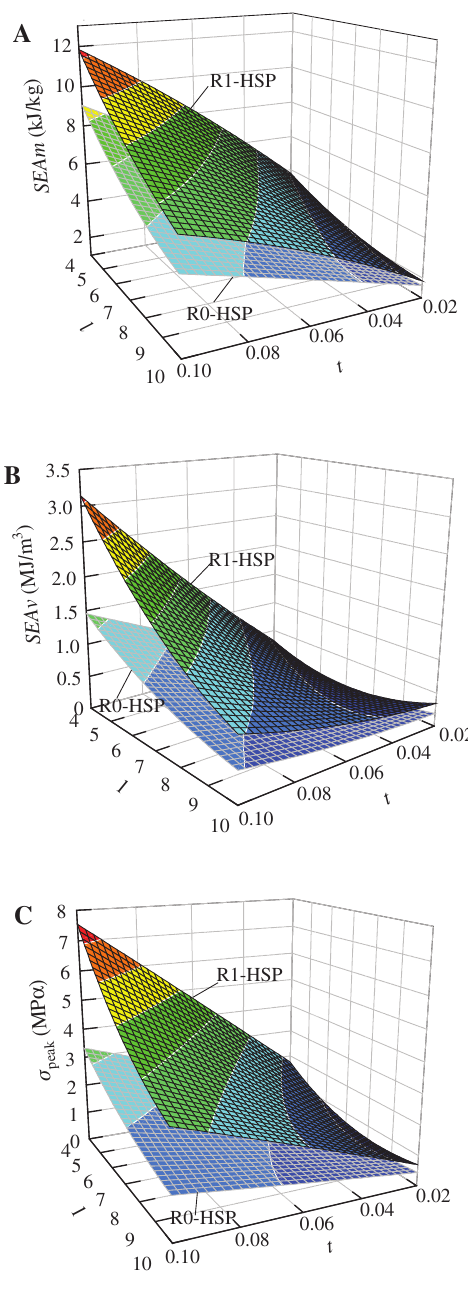
Figure 8: Response surface maps of R0-HSP and R1-HSP on crash- worthiness indicators.